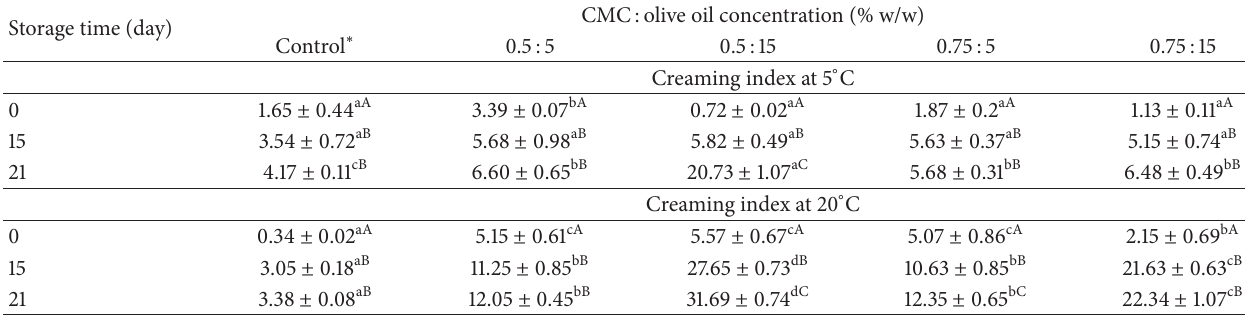
Table 4: Creaming index of O/W nanoemulsions stabilized by CMC and with different olive oil concentration during 21 days of storage at 5 ∘ C and 20 ∘ C.